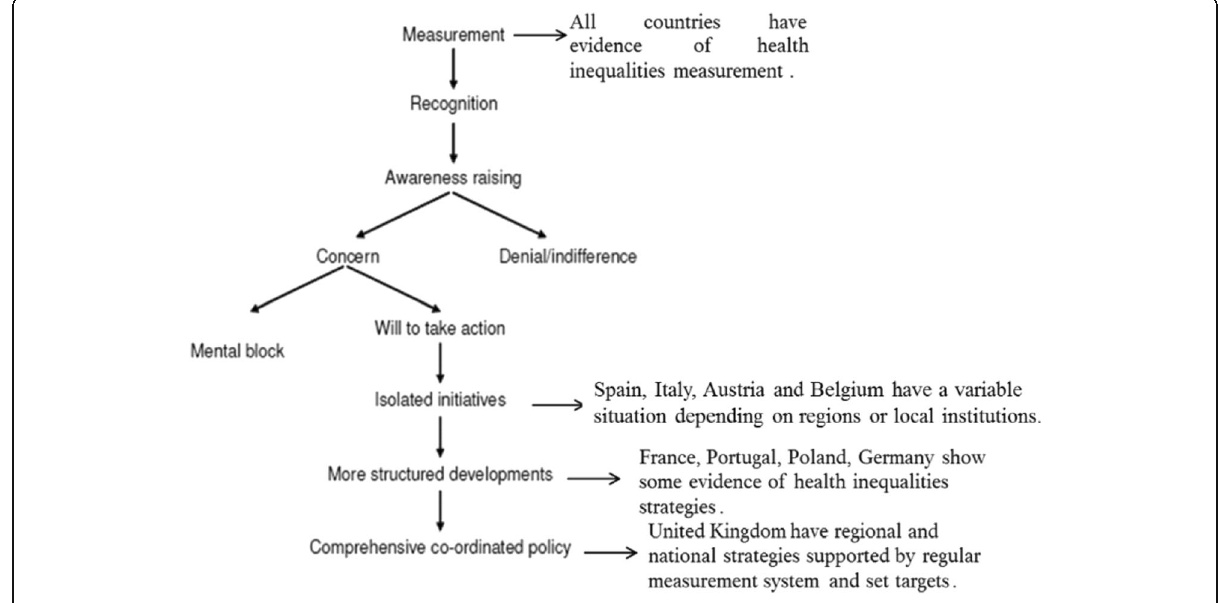
Fig. 1 Action spectrum of inequalities and AIR survey